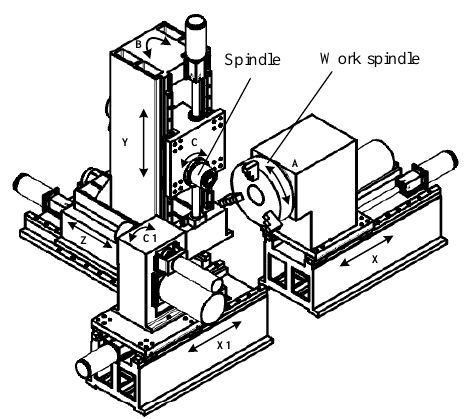
Figure 13. Structural diagram of honing machine tool.